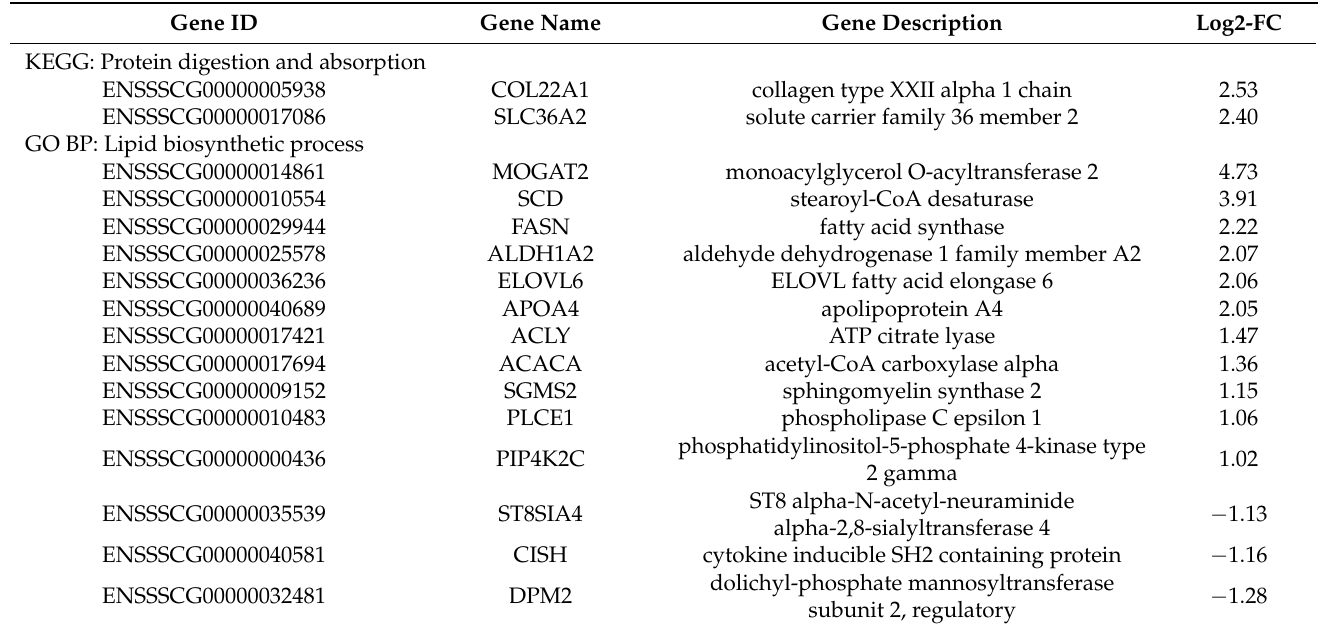
Table 5. DEGs in the skeletal muscle of the ZQ-1 g pigs in comparison to the control